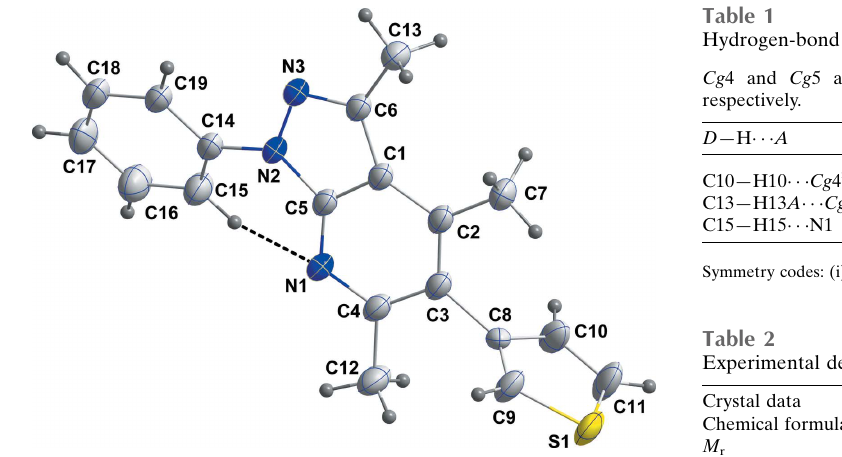
Table 1 Hydrogen-bond geometry (A˚ , (cid:3) ).